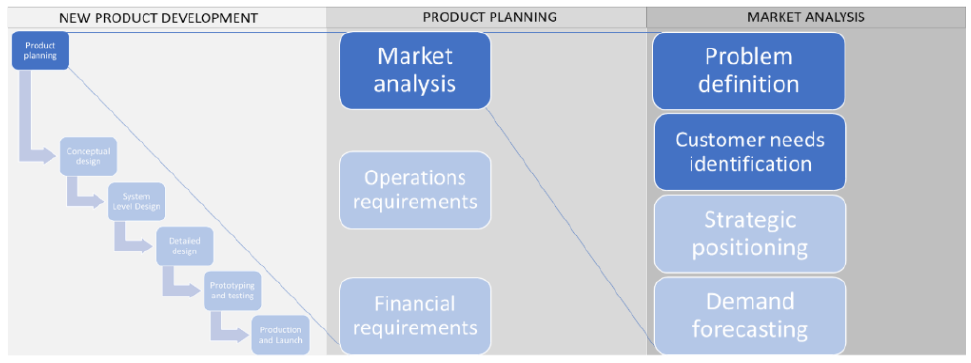
Fig. 2 : New product development: problem definition and customer needs identification.